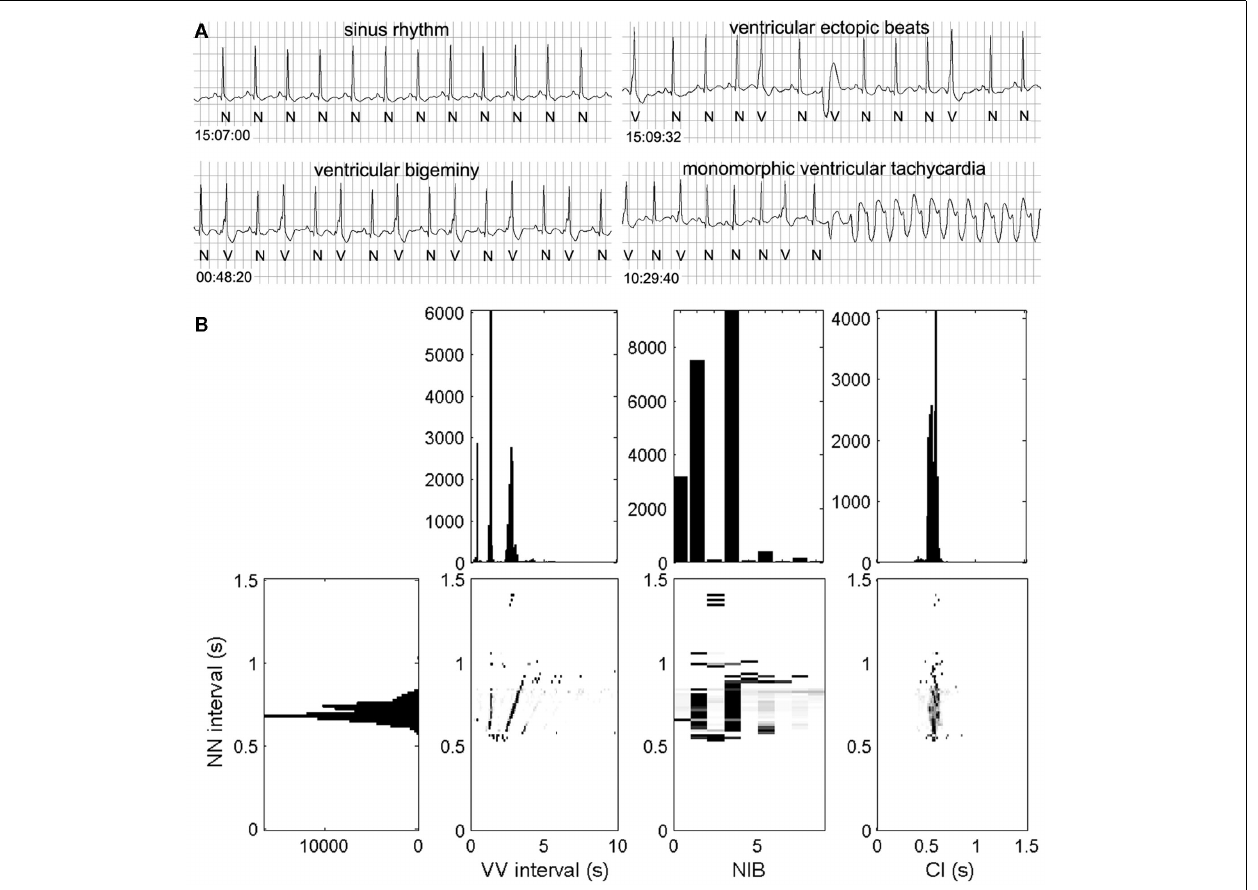
beats (NIB) were mostly 0, 1 and 3, and the coupling interval (CI) was relatively fixed. Case 44 from the PhysioNet Sudden Cardiac Death Data Base (Goldberger et al., 2000). For abbreviations, see